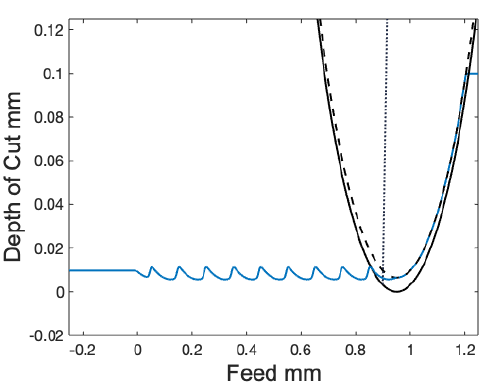
Figure 8. Surface profile created by the iterative model, shown at equilibrium after Gaussian filtering.